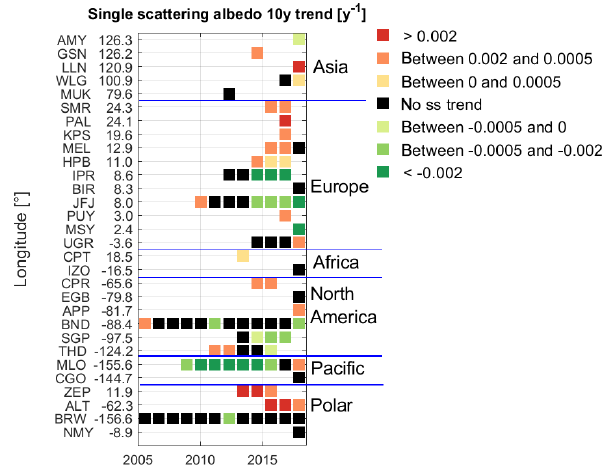
Figure 14. Time series of sequential 10-year ω 0 trends as a function of station